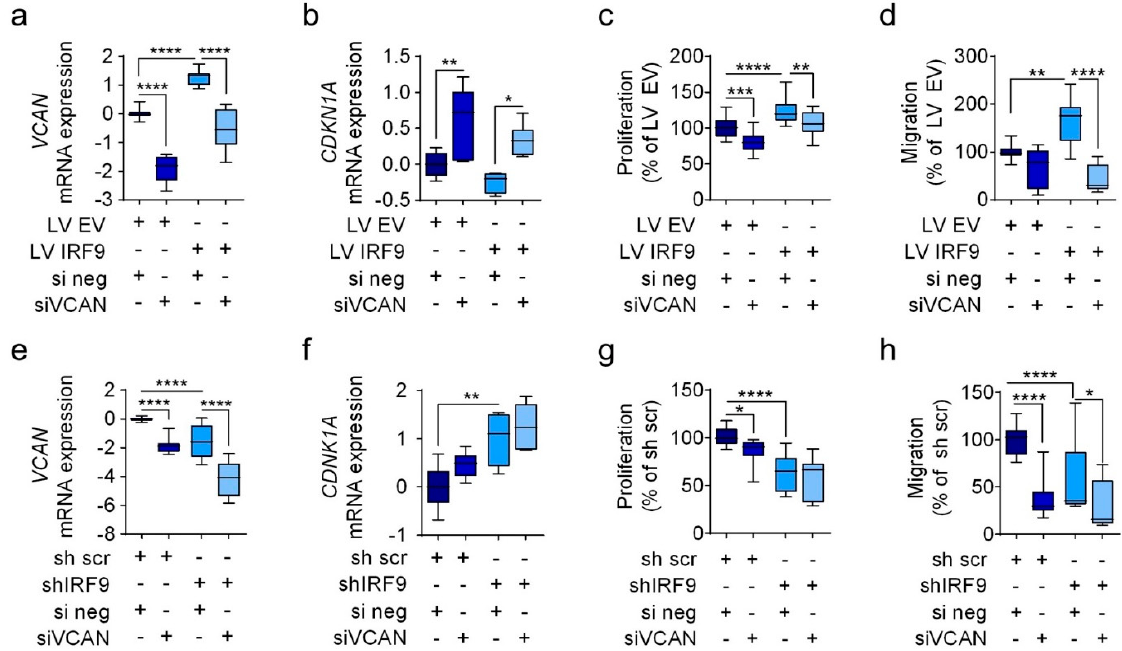
Figure 6. VCAN knockdown diminishes the oncogenic features of IRF9. Transduced A549 IRF9 cells were transfected with siRNA against VCAN (siVCAN) to knockdown VCAN expression. A non-targeting sequence was used as a transfection control (si neg). ( a , e ) mRNA expression of VCAN in LV IRF9 and shIRF9 cells; mRNA expression was calculated as ∆∆ Ct ( n = 4). ( b , f ) mRNA expression of CDKN1A in LV IRF9 and shIRF9 cells; mRNA expression was calculated as ∆∆ Ct ( n = 4). ( c , d ) Proliferation and migration of siVCAN in A549 LV IRF9 cells ( n = 3). ( g , h ) Proliferation and migration of siVCAN in A549 shIRF9 cells ( n = 3). Data are shown as means ± standard error of the mean. Analysis was via one-way ANOVA: * p < 0.05; ** p < 0.01; *** p < 0.001; **** p <